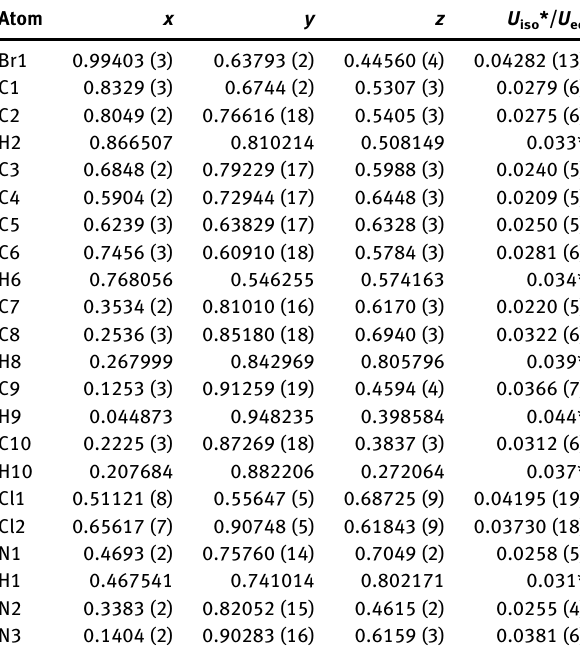
Table  : Fractional atomic coordinates and isotropic or equivalent isotropic displacement parameters (Å 